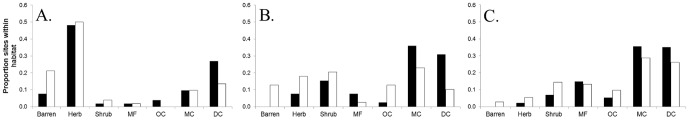
Habitat class at 279 grizzly bear resting sites and 279 random sites in west-central Alberta, Canada, by land designation:A. Reclaimed mines (n1 = 52 bedding sites), B. protected areas (n2 = 39 bedding sites) and C. Crown lands (n3  = 188 bedding sites). Classification includes barren land (Barren), herbaceous (Herb), shrub (Shrub), mixed forest (MF), open conifer forest (OC), moderate conifer forest (MC) and dense conifer forest (DC).